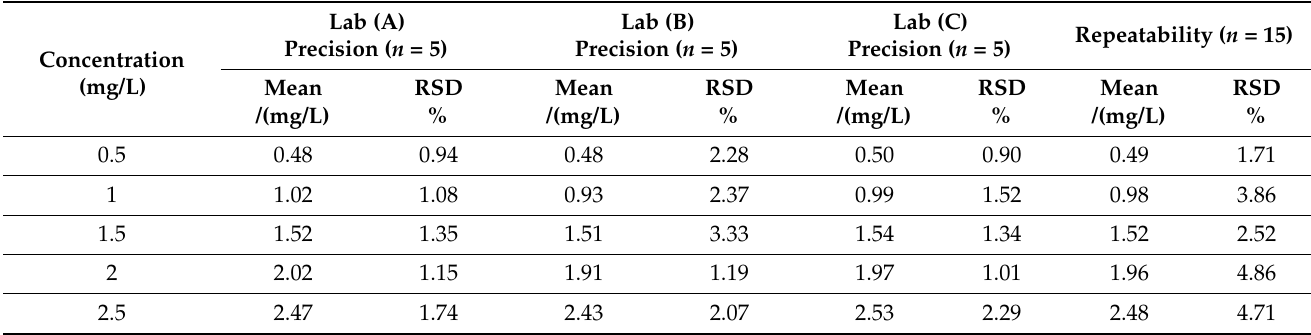
Table 2. Precision and repeatability of test kit method.